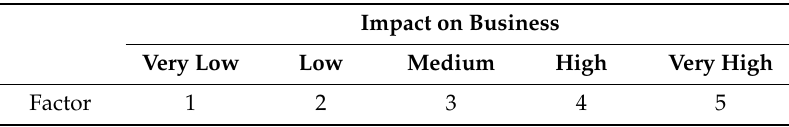
Table 1. Weight Factor based CIA.